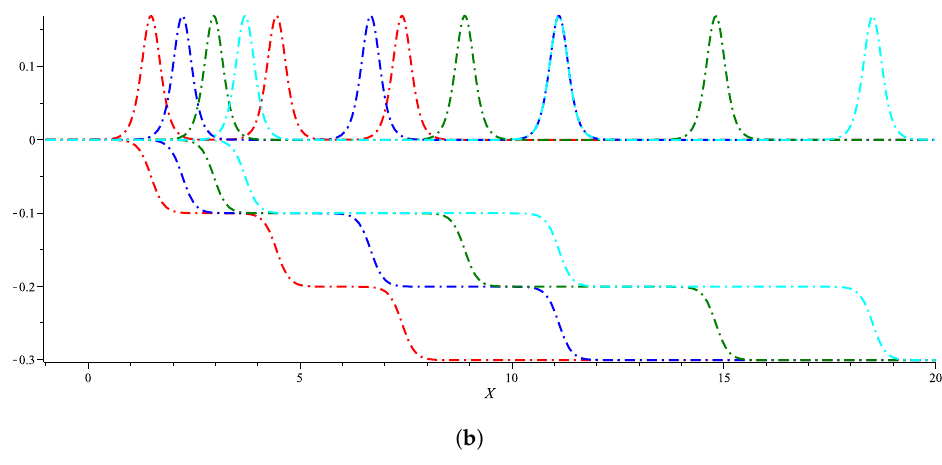
Figure 8. Rarefactive electrostatic overtaking collision of shock wave (lower curves) and its corresponding electric field behaviors (upper curves) for ( a ) N = 2 and ( b ) N = 3 with T = 10 (red color), 15 (blue color), 20 (green color), 25 (cyan color), α = 0 and q = 1, M r = 3.75, T ni = 0.05, T e = 0.2, N r 1 = 0.9, N r 2 = 0.5, µ ni = 0.05, and µ pi =